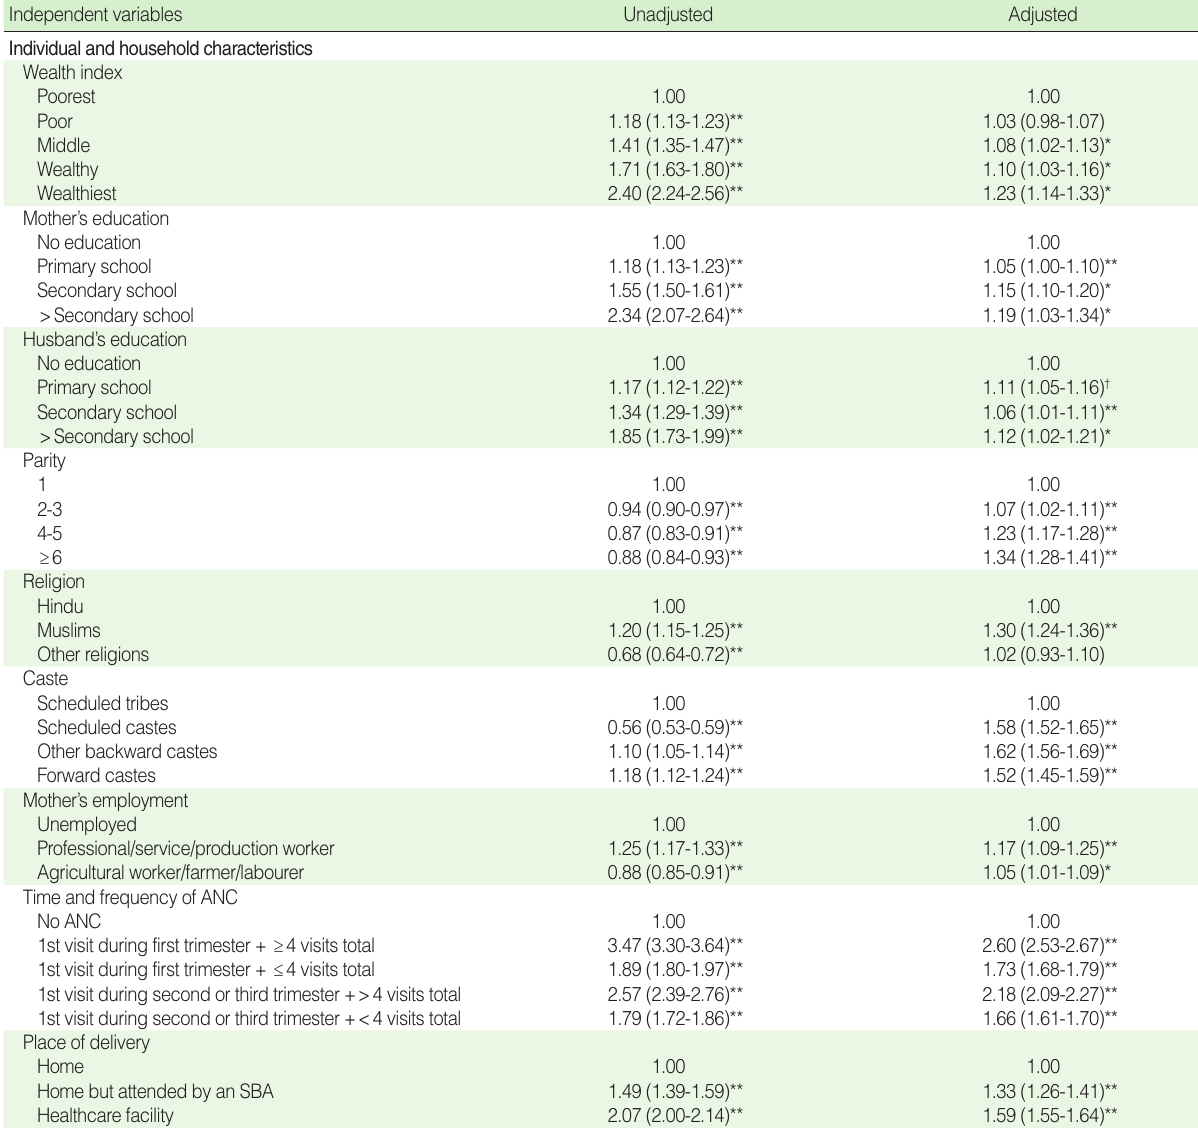
Table 3. Unadjusted and adjusted odds ratios (ORs) for treatment-seeking among currently married women (aged 15-49 years) residing in rural India, who experienced one or more postpartum morbidities within six weeks after delivery Independent variables Unadjusted Adjusted Individual and household characteristics Wealth